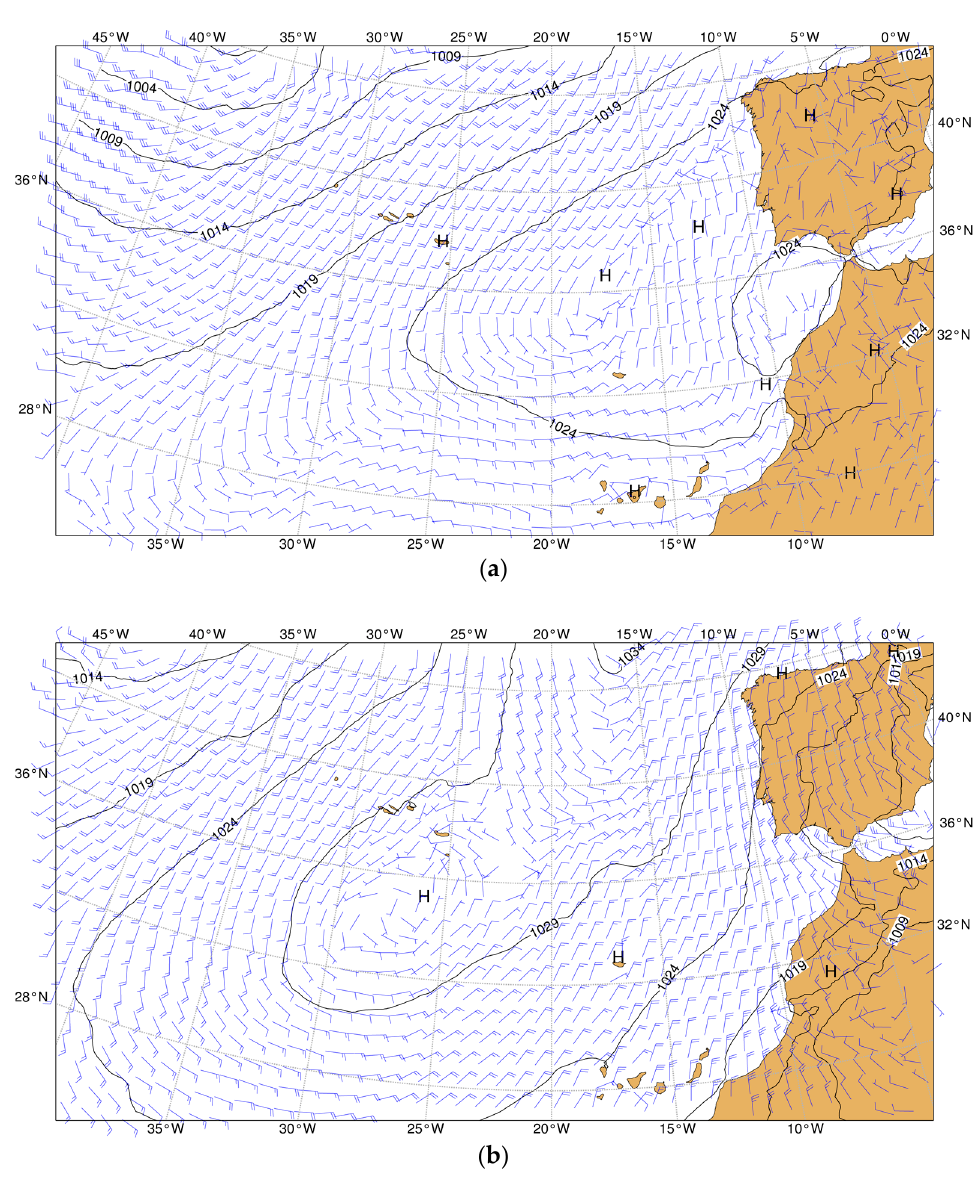
Figure 6. Mean sea level pressure (in hPa) and 10 m wind (kt) based on ECMWF analysis for: ( a ) Flight 1; ( b ) Flight 2. Table 3. Froude number and related results by flight for Point C in Figure 2 with h c 1 , h c 2 , z i in meters. Parameter Flight